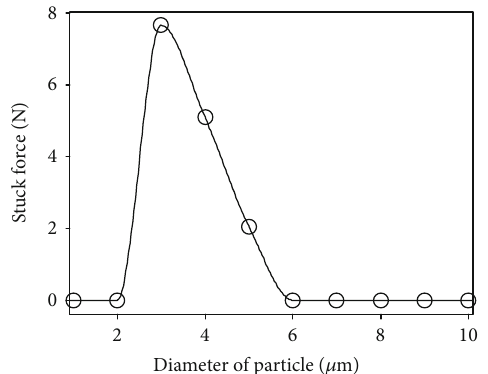
Figure 23: The relation curve between the friction force and oil pollution